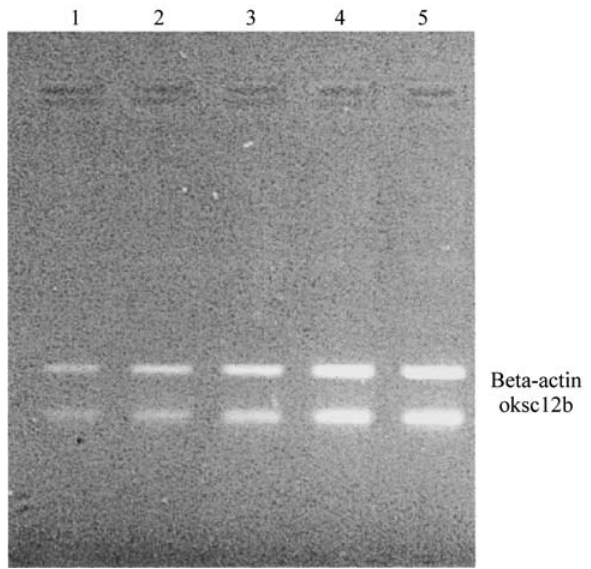
Figure 1 - 2% agarose gel separation of RT-PCR fragments correspond - ing to oksc12b gene (169 bp) and beta-actin gene (218 bp) amplified from cDNA of a normal control. Lanes 1 to 5 correspond to an equivalent of 5, 10, 20, 40, and 60 ng of RNA.